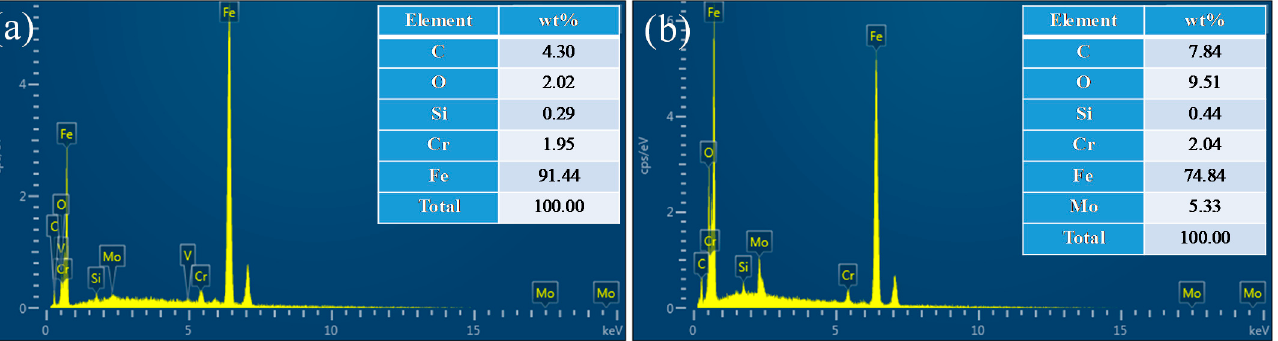
Figure 7. Energy dispersive spectrum (EDS) profiles of ( a ) the matrix, and ( b ) the inclusion marked by red “+” in Figure 6d.